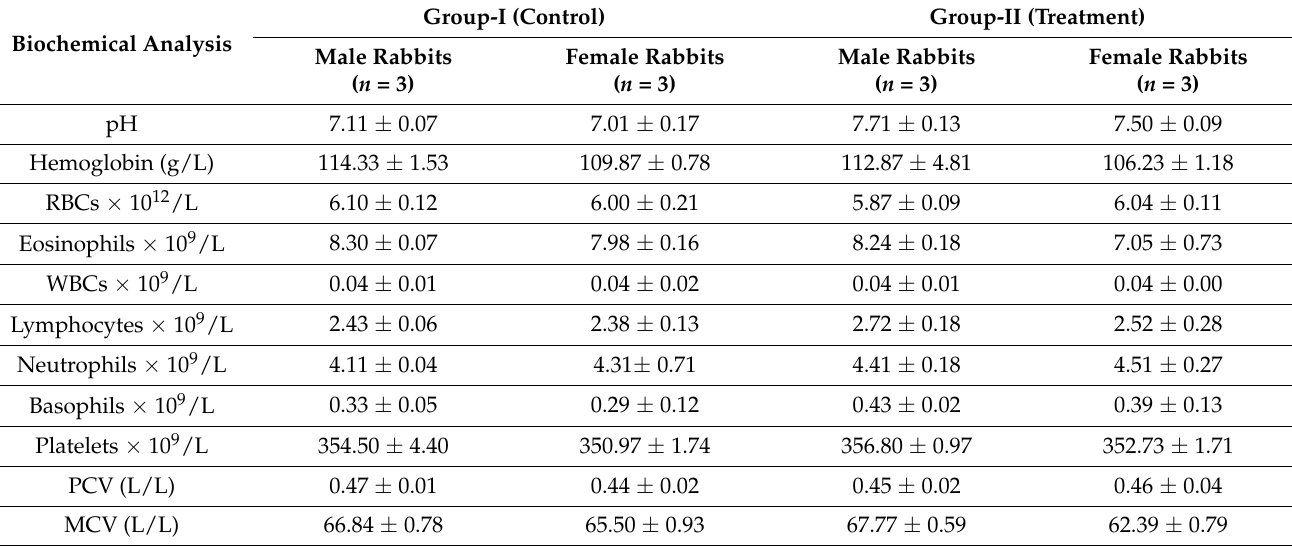
Table 4. Hematological profile (hydrogel dispersion) of the control and treatment groups ( n = 6 rabbits: 3 male rabbits and 3 female rabbits) for